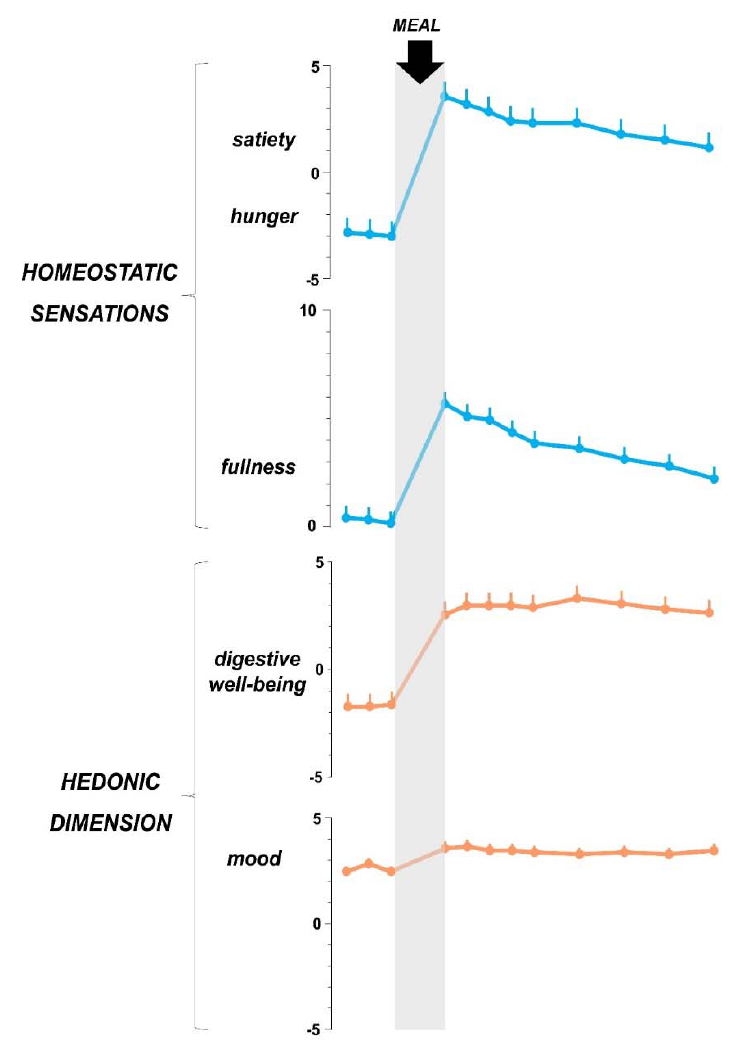
Figure 2. Sensations related to food ingestion. In healthy women ( n = 12) a. palatable comfort meal induced homeostatic sensations (satiety, fullness) with pleasant hedonic dimension (increased digestive well ‐ being and mood). Data from reference 79.